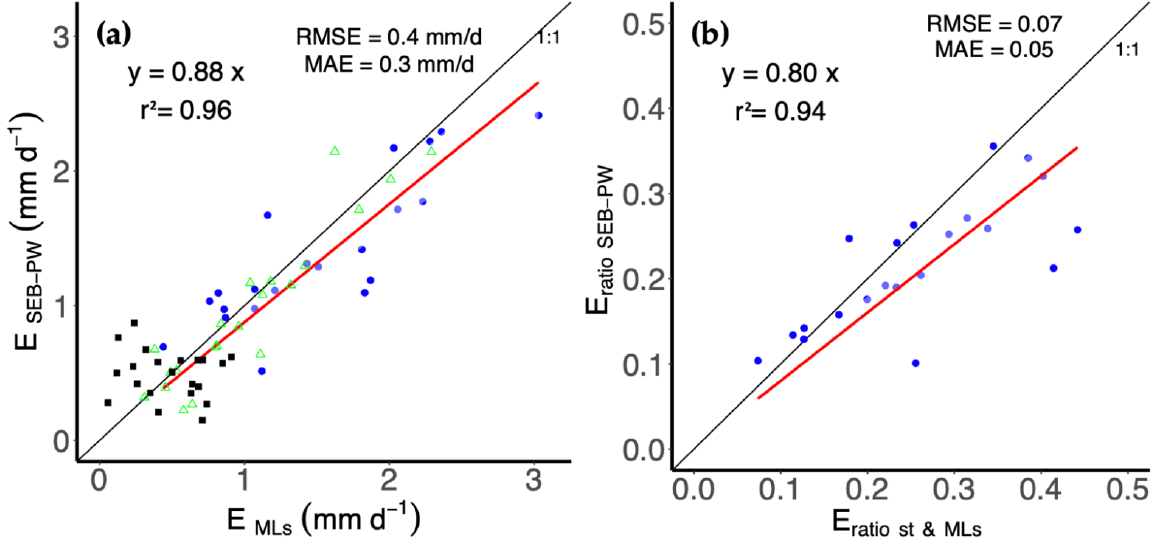
Figure 11. Relationship between daily E ( a ) and E ratio ( b ) estimated by the SEB – PW model and measured with ET stations and micro – lysimeters (MLs). Black squares and green triangles represent non-wetted and wetted areas, respectively, and blue circles represent the mean of soil E. As with diurnal E, measured E ratio was higher the first day after irrigation, with values ranging between 34% and 39% of total ET at site S1 and 29% and 42% of total ET at site S2 (Figure 11b). The modeled E ratio was also higher on the first day after irrigation at both sites, with values ranging between 27% and 32% of total ET at site S1 and 26% and 34% of total ET at S2. Meanwhile, lower E ratio values were measured on the second day after irri- gation at site S2 and the fifth day after irrigation at site S1, averaging 18% and 13%, re- spectively. Similar values were simulated by the SEB-PW model. Daily E from non-wetted areas measured with MLs (black squares, Figure 11a) was 32% of total daily E at site S1 and 35% of total daily E at site S2, similar to values found by the SEB-PW model. Daily E from wetted areas (green triangles, Figure 11a) was 68% of the total diurnal E at site S1 and 65% at site S2. Similar E ratio values were reported in the literature when measured daily E ratio values were compared to predictions from energy balance models [18,21,48,49]. Based on the statistical parameters (Table 3), the calibrated SEB-PW model showed good